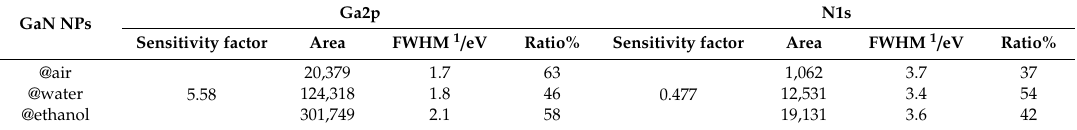
Figure 4. X-ray photoelectron spectroscopy (XPS) spectra of GaN-NPs: ( a ) and ( b ) from N1s and Ga2p of GaN-NPs@air; ( c ), ( d ) and ( e ) are from N1s, Ga2p and Ga3d in GaN-NPs@ water; ( f ), ( g ) and ( h ) are respectively from N1s, Ga2p and Ga3d of GaN-NPs@ethanol. Table 1. The contents of Ga and N elements in GaN-NPs@air, GaN-NPs@water and GaN-NPs@ethanol .